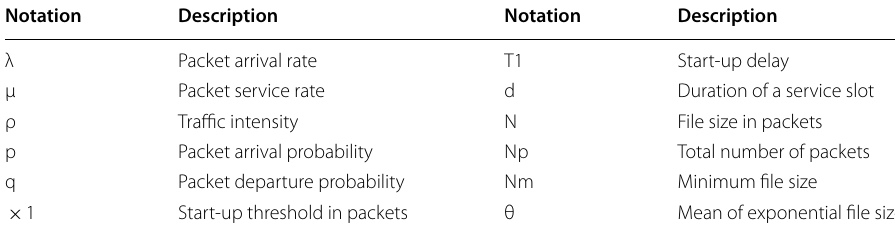
Table 1. The elements contained in the state